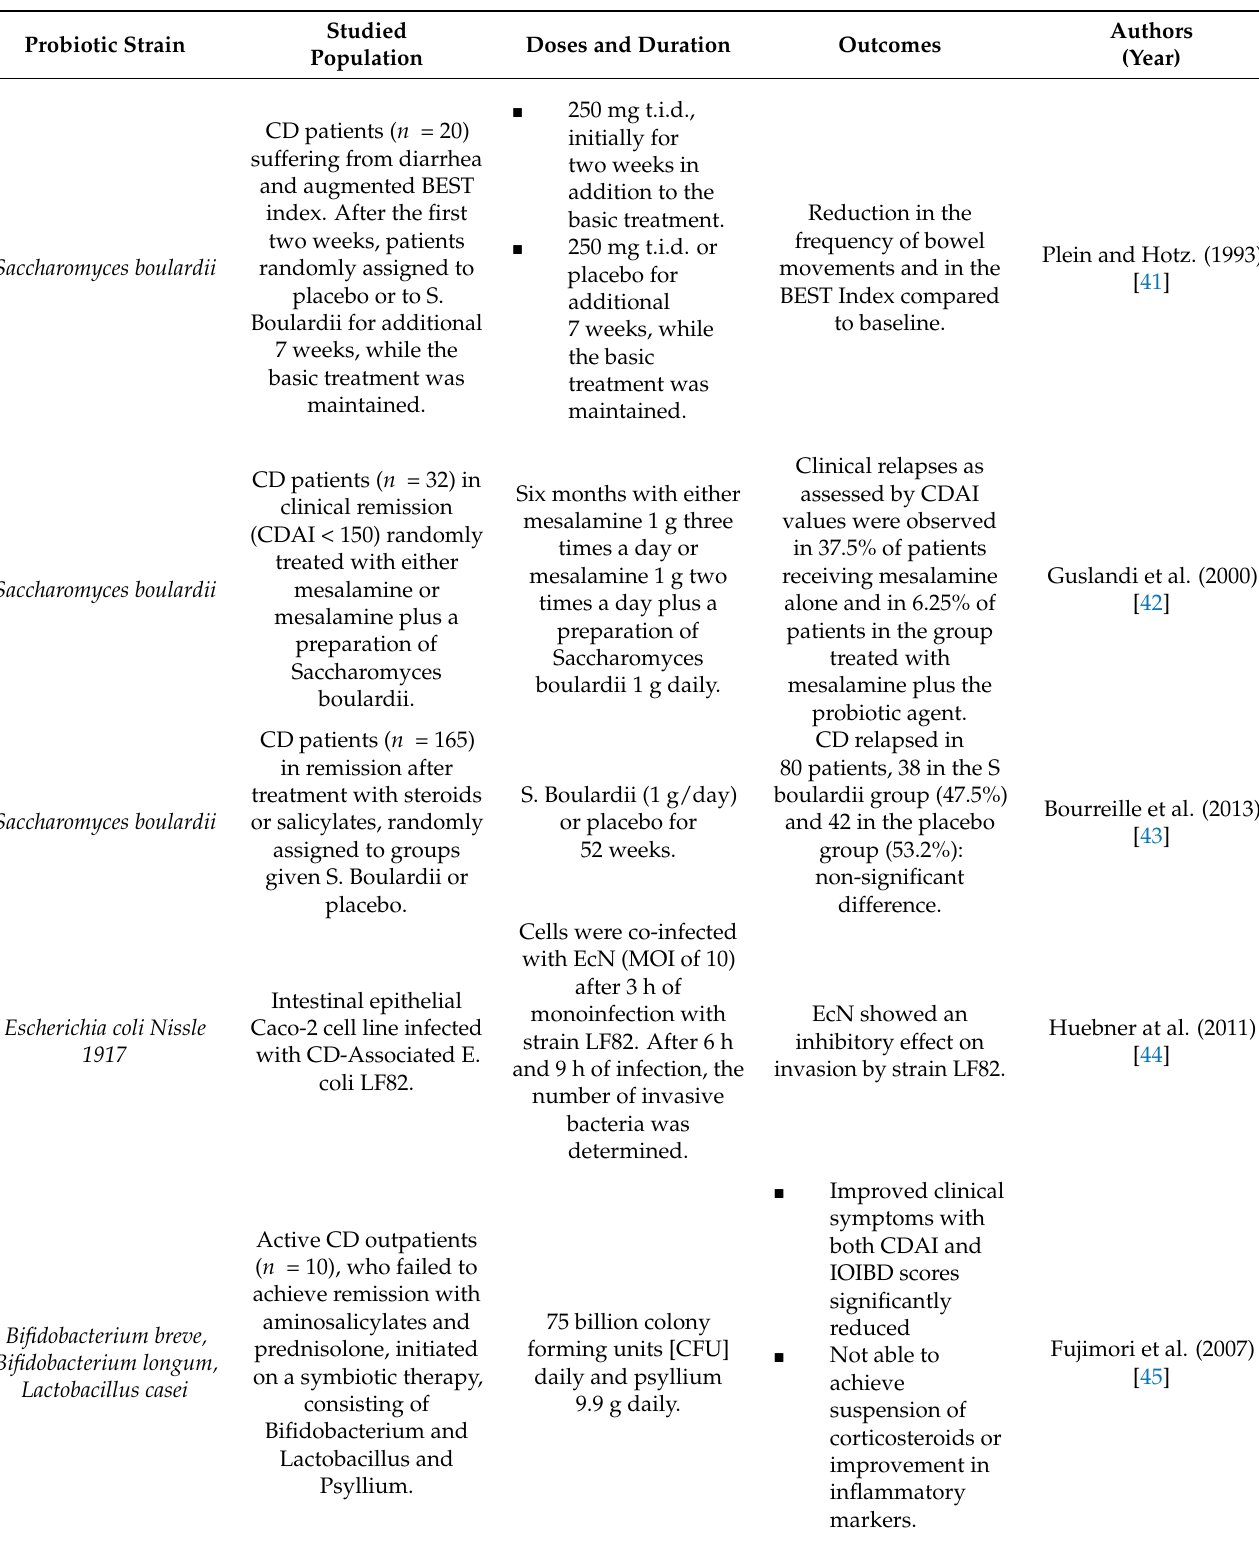
Table 2. Overview of studies testing probiotics strains in CD. Note the high degree of heterogeneity in terms of probiotic formulations, duration of treatment, study design and target population (active vs. quiescent